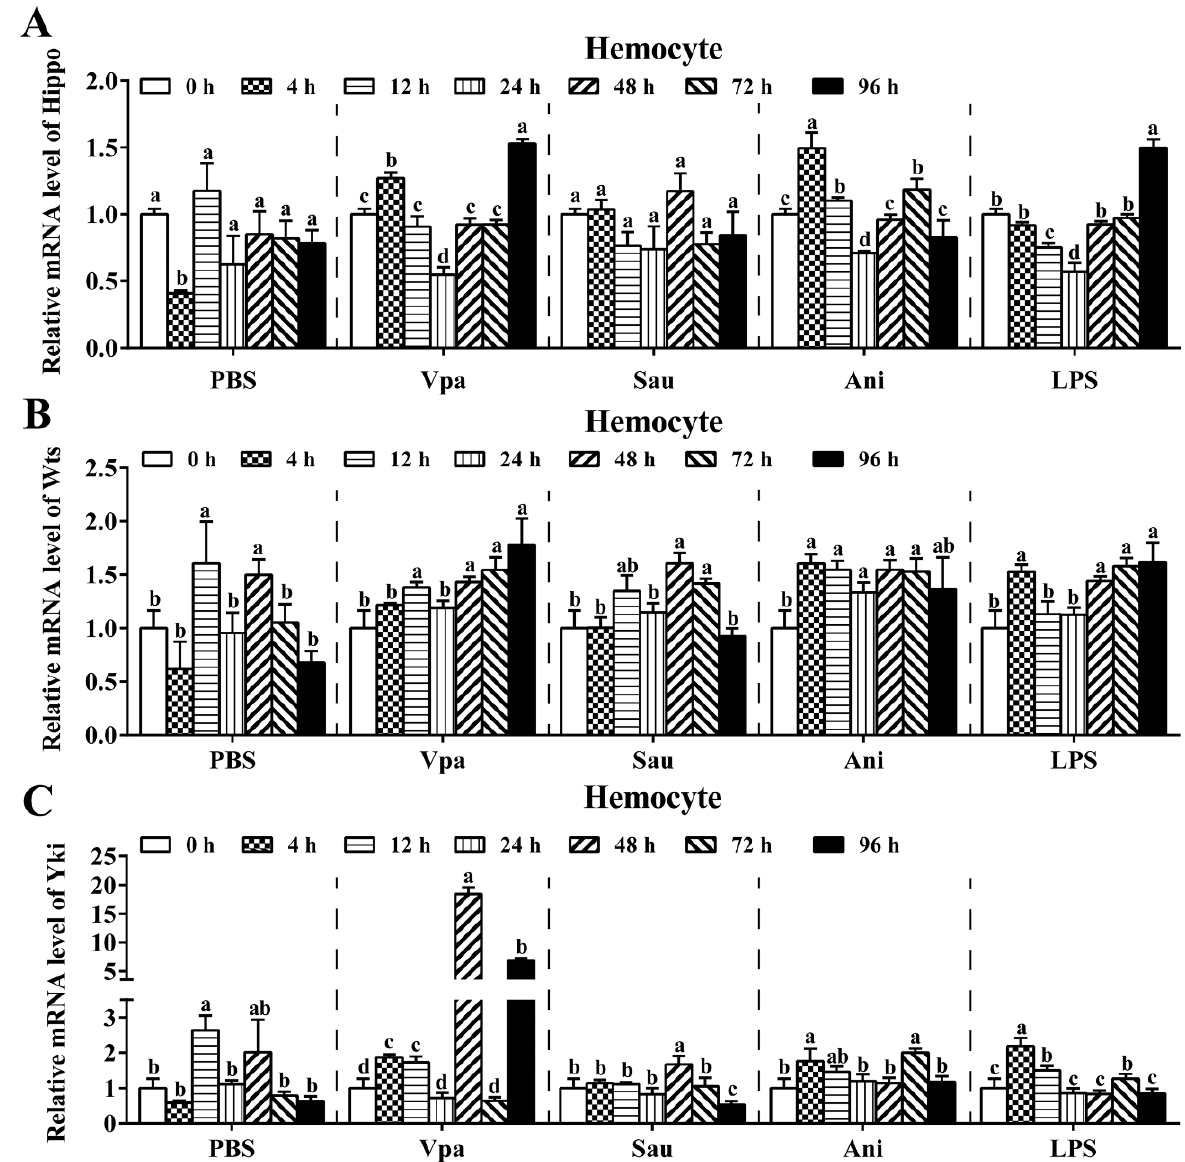
Figure 1. Expression of the Hippo signaling components in shrimp infected with bacteria and fungi. The mRNA levels of Hippo ( A ), Wts ( B ), and Yki ( C ) in hemocytes after V. parahaemolyticus (Vpa), S. aureus (Sau), A. niger (Ani), LPS, and the control PBS were detected using relative qPCR. For each challenge group, the data at 0 h was set as 1.0 after normalizing to the geometric mean expression of the internal controls β -actin and Ef-1 α . Values with different letters indicated significant differences by one-way ANOVA, followed by Dunnett’s post hoc test ( p < 0.05).